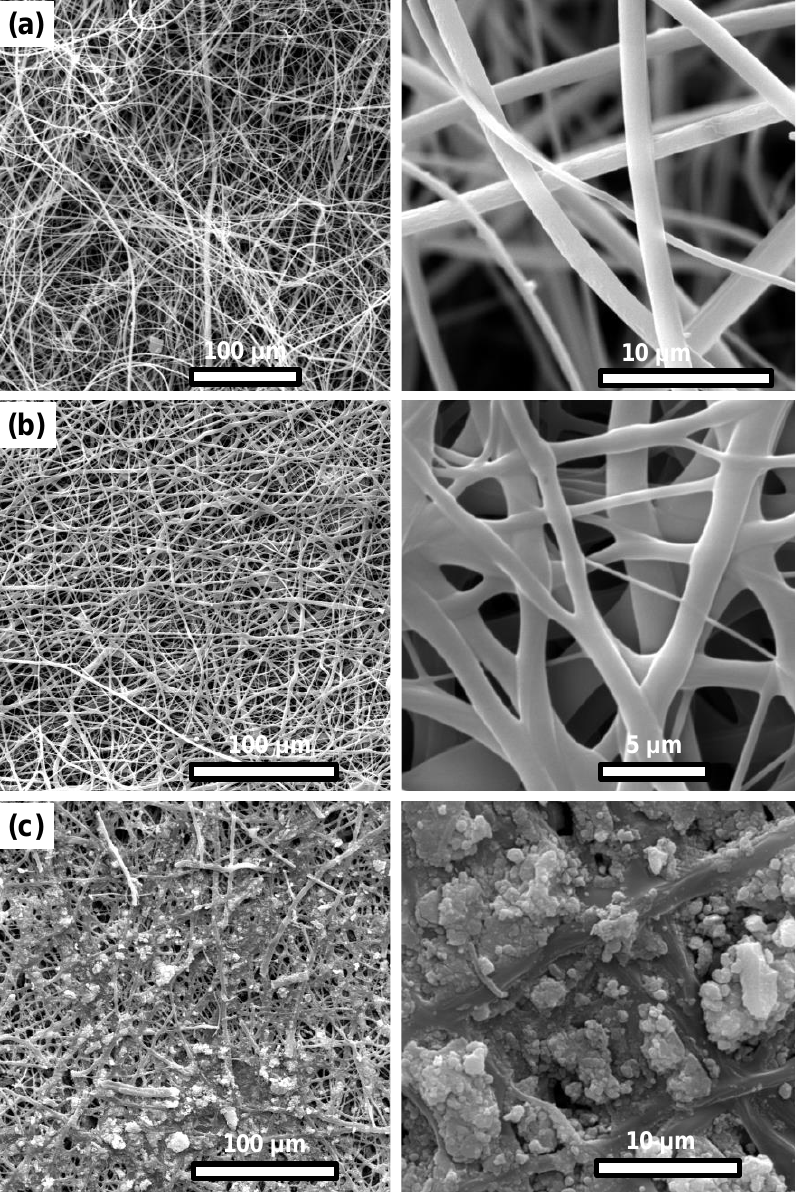
Figure 6. Representative SEM images of PMMA x -co-PDEAEMA y /PVP (as-prepared) ( a ), PMMA x - co-PDEAEMA y /PVP (crosslinked) ( b ) and PMMA x - co -PDEAEMA y /PVP/Fe x O y (magnetically func- tionalized) electrospun membranes ( c ).